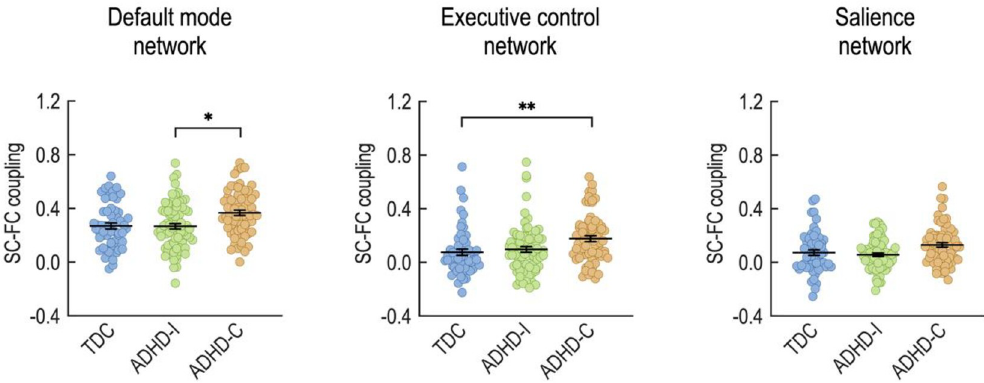
Fig 4. Structure-function coupling results for the ADHD-related subnetworks. � p < 0.05. �� p < 0.01 (two-sample